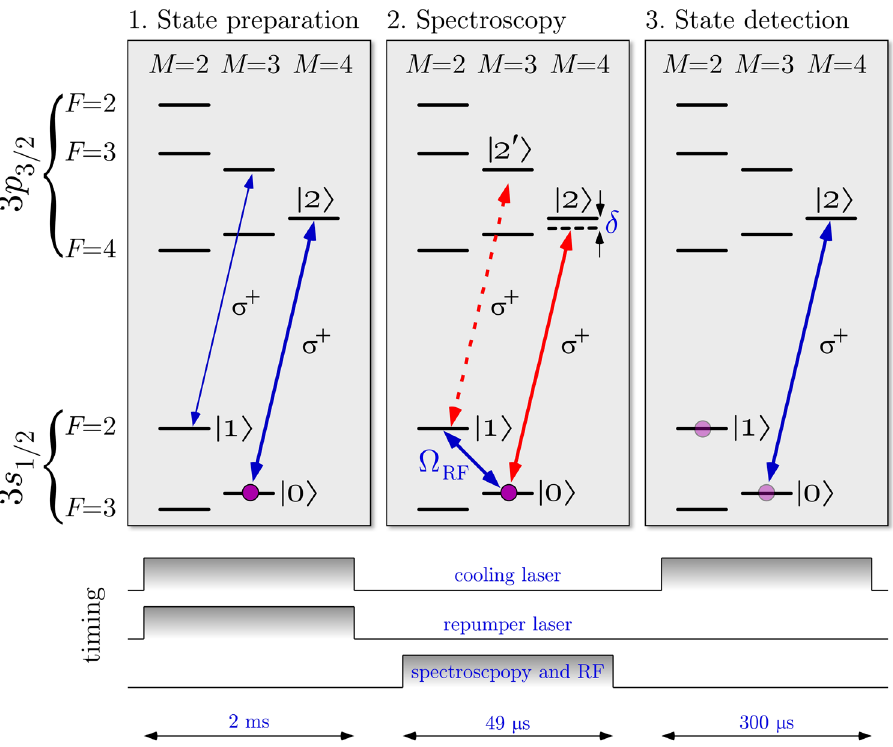
Figure 5. In the first step the ion is prepared (and cooled) in the |0 〉 = 3 s 1/2 ( F = 3, M = 3) state by optical pumping with a continuous wave laser. Then Zeno spectroscopy is performed by observing the damping of Rabi flopping of the |0 〉 = 3 s 1/2 ( F = 3, M = 3) → |1 〉 = 3 s 1/2 ( F = 2, M = 2) driven with a radio frequency of 1.785 GHz (see Fig. 3). Zeno spectroscopy also works for the non-cycling transition to |2 ′ 〉 (dashed). Since the spectroscopy laser in this case is a frequency comb, we see both transitions convolved with the comb (see Fig. 6). In the last step the population remaining in the initial state is determined. At this point we simply use the same laser as cooling/preparation laser on its cycling transition for a demonstration whereas in a real application such a laser would not exist (otherwise the usual shelving or fluorescence detection scheme seem to be simpler). The preparation and state detection would have to be done by other means such as state dependent trap losses 18